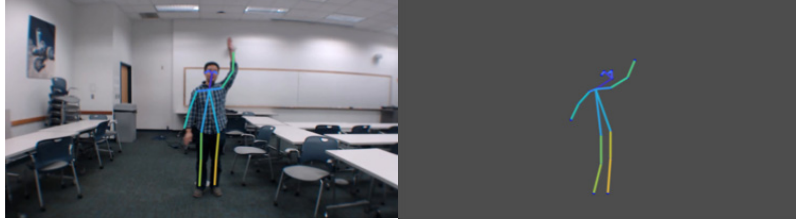
Figure 8. The Two-dimensional human skeleton is generated by 2.4 GHz Wi-Fi CSI [49]. The ground truth is shown on the left, and the CSI predicted skeleton is shown on the right.